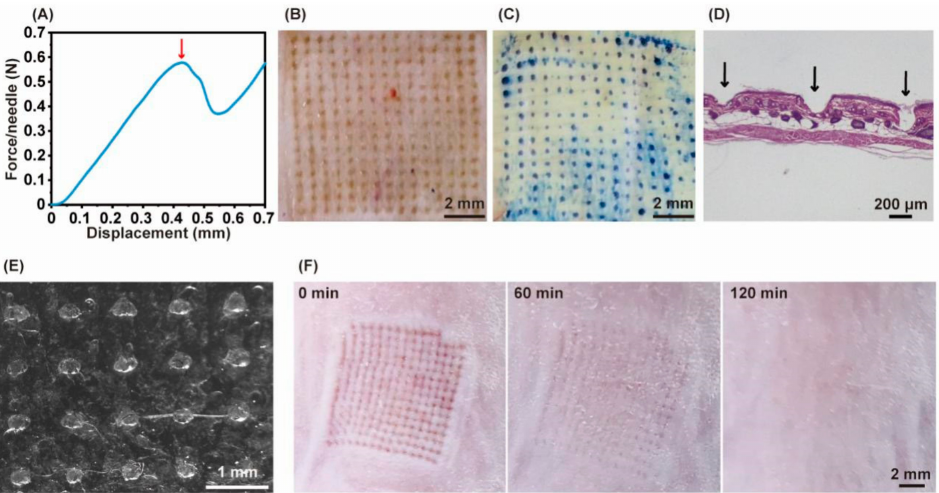
Figure 3. ( A ) Examination of the failure force per needle; the separated mouse dorsum skin ( B ) and trypan blue stained skin image ( C ); ( D ) H&E-stained cross-section of inserted skin by MN; ( E ) MN image after application to the mouse skin for 90 min; ( F ) skin recovery images at 0 min, 60 min, and 120 min after MN